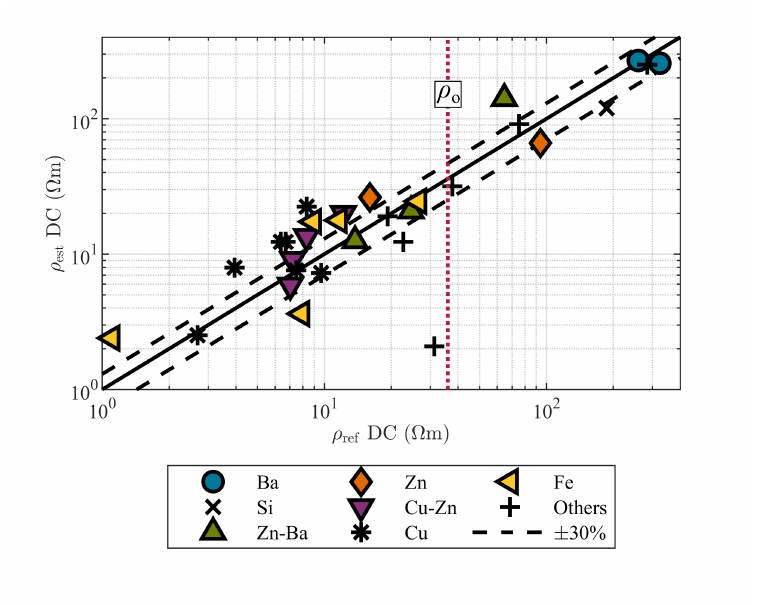
Figure 10. Estimated target resistivity at the lowest measured frequency vs. resistivity of the reference measurement for all 30 samples. The red dotted line indicates the resistivity of the outer medium ρ o at 36 Ω